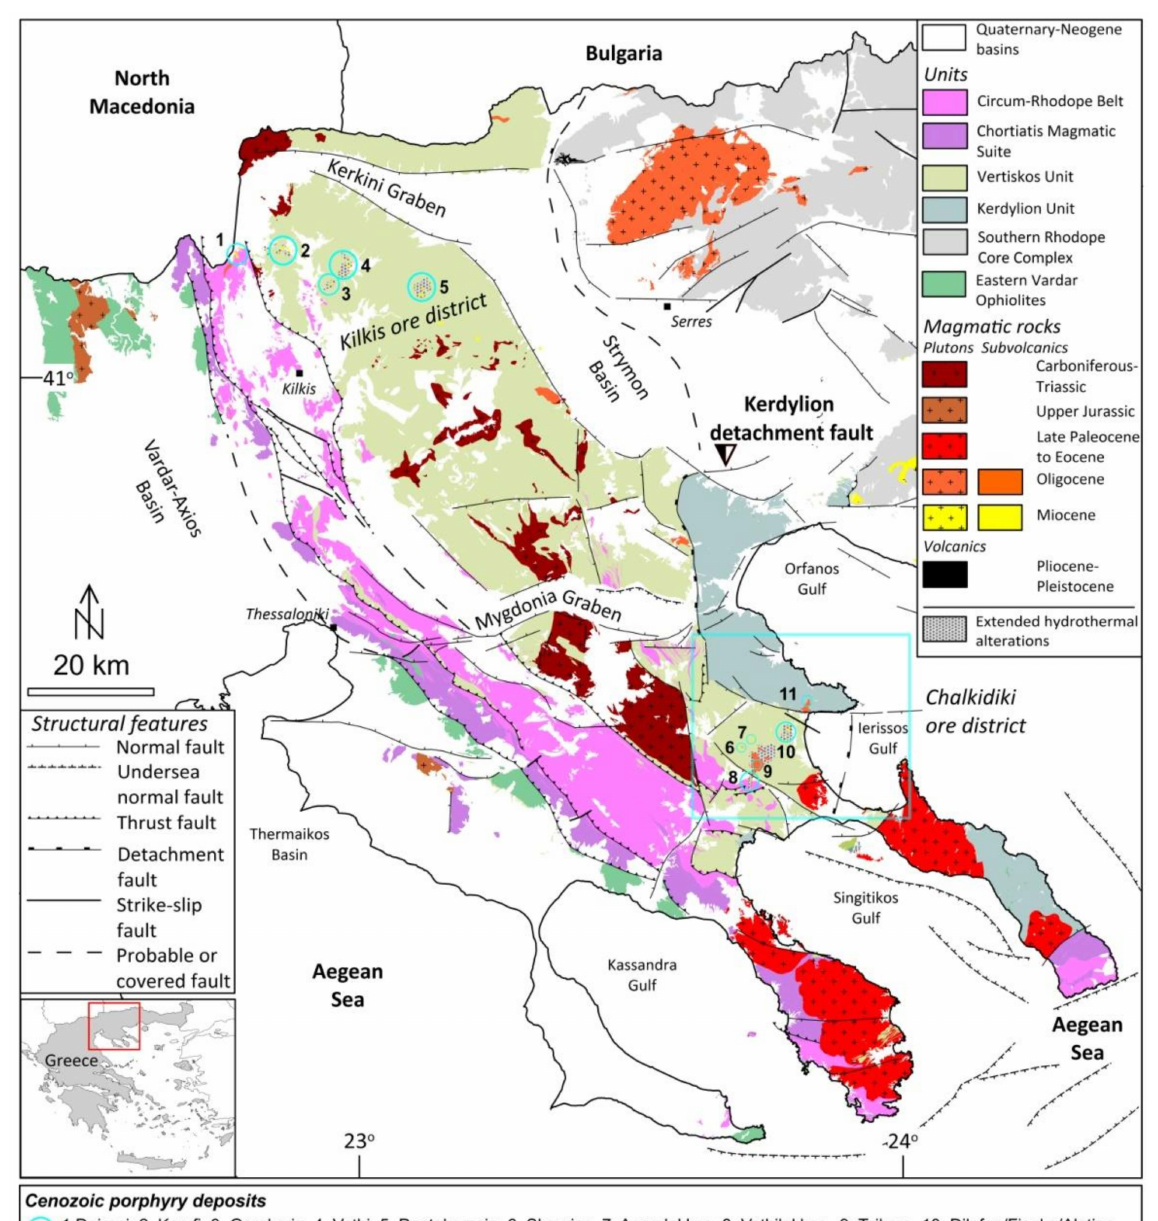
Figure 1. The geological setting of the Cenozoic magmatic rocks and related porphyry-type mineralization of the Vertiskos Unit (modified after